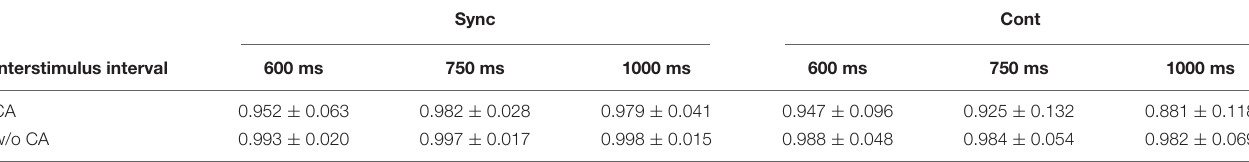
TABLE 3 | The mean and standard deviation of the interval reproduction accuracy